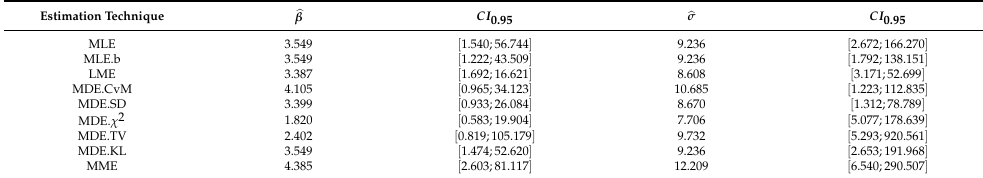
Table 6. Estimated parameters for the airborne communication transceiver dataset (with a 95% percentile bootstrap confidence